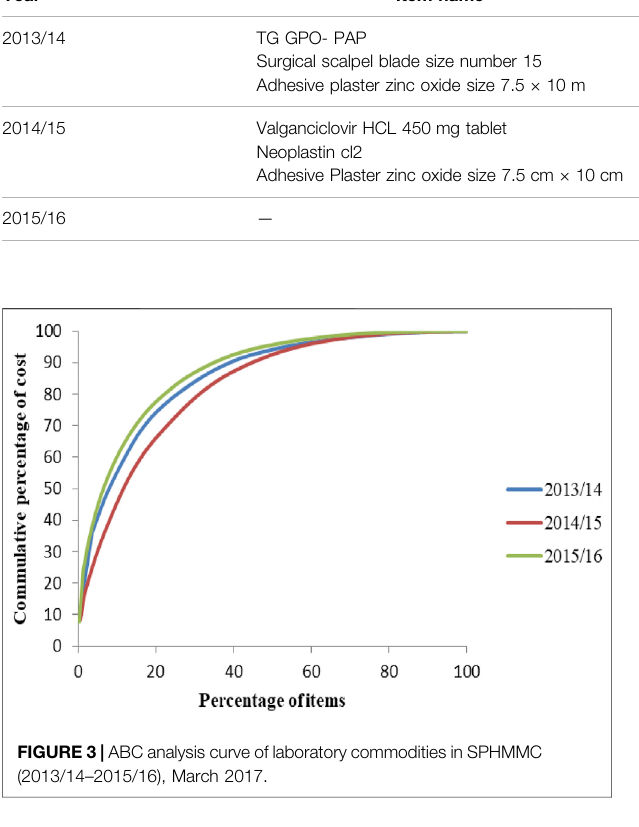
Frontiers in Pharmacology |